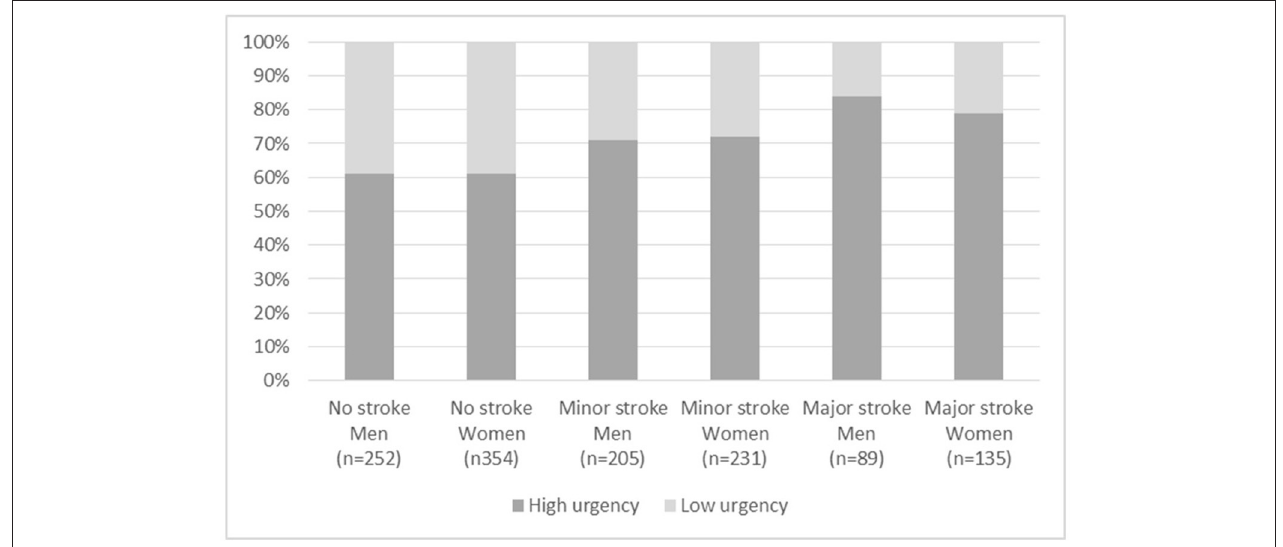
FIGURE 1 | Allocated urgency by clinical diagnosis in women and men. Data are presented as n (%) and statistical differences were calculated with χ 2 test. U1–2, NTS level of urgency; 1 = life threatening; 2 = emergent. U3–5, NTS level of urgency; 3 = urgent, 4 = nonurgent, 5 =